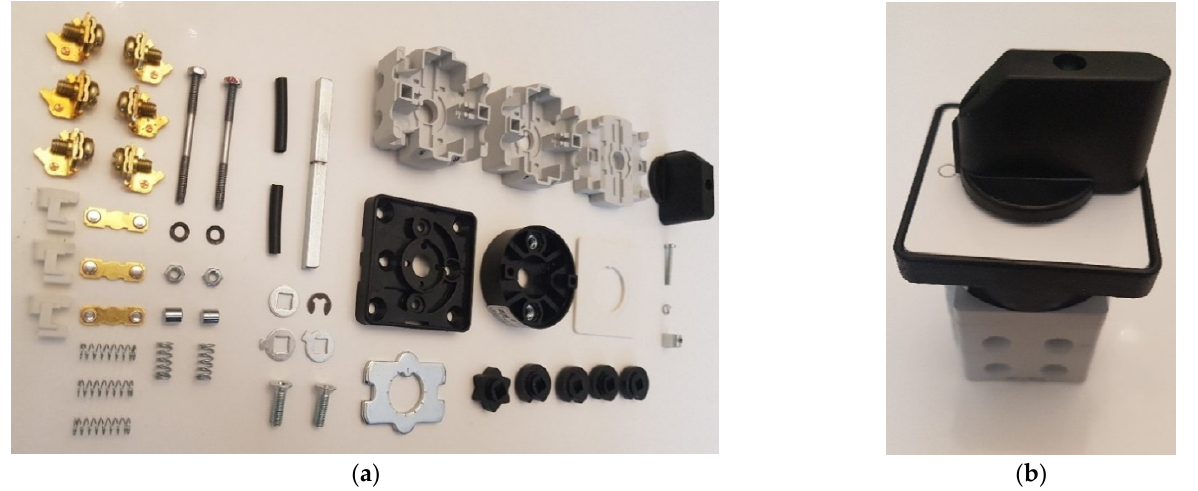
Figure 4. The experimental product used in research: ( a ) The disassembled product parts for identification by CNN; ( b ) The assembled cam switch.